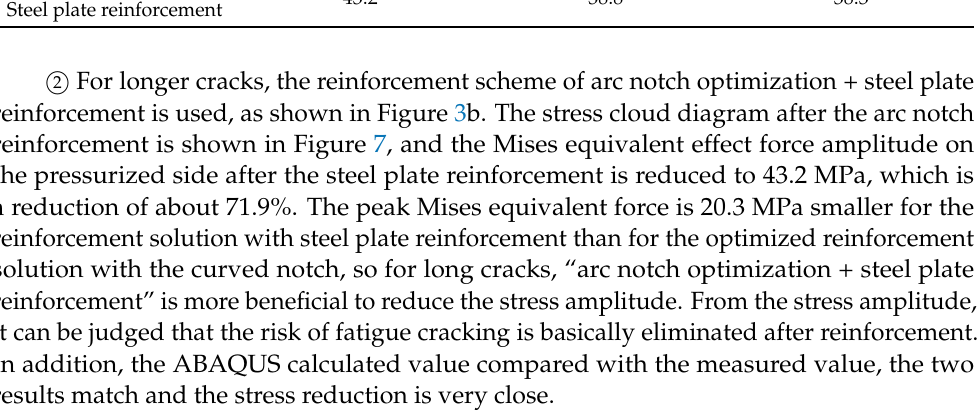
6 of 19 Table 2. Stress comparison before and after arc notch optimization reinforcement (MPa).